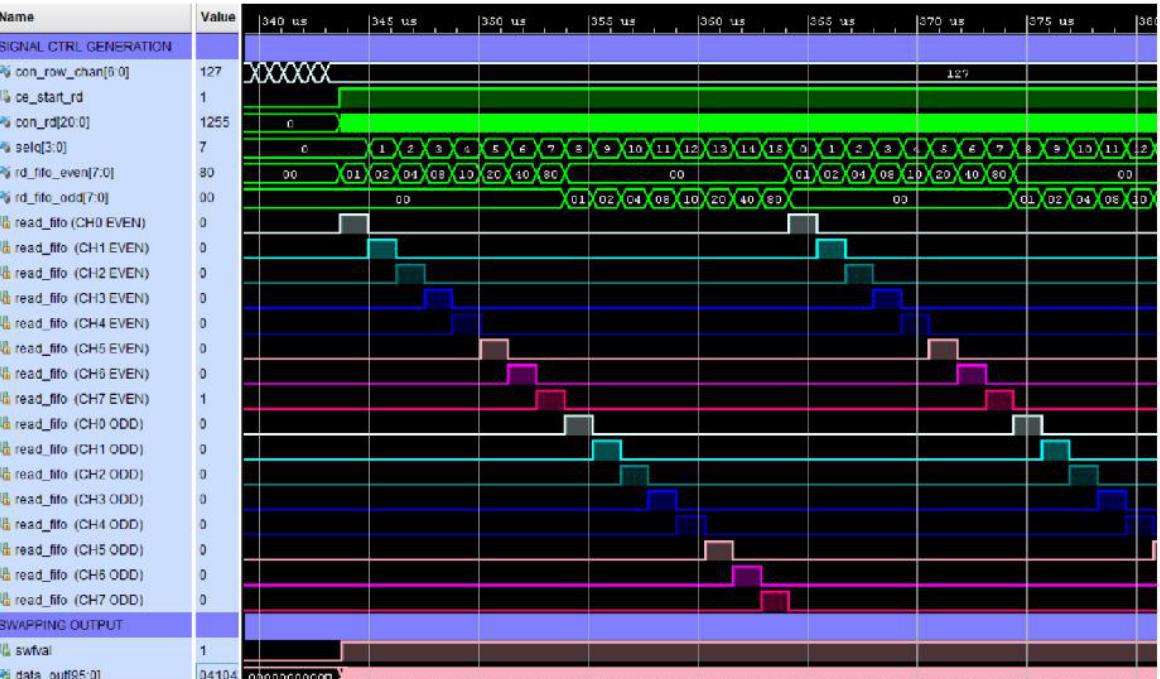
Figure 11. Simulation of the FIFOs reading and data output of the swapping module. Table 4. Bit description of con_rd signal.